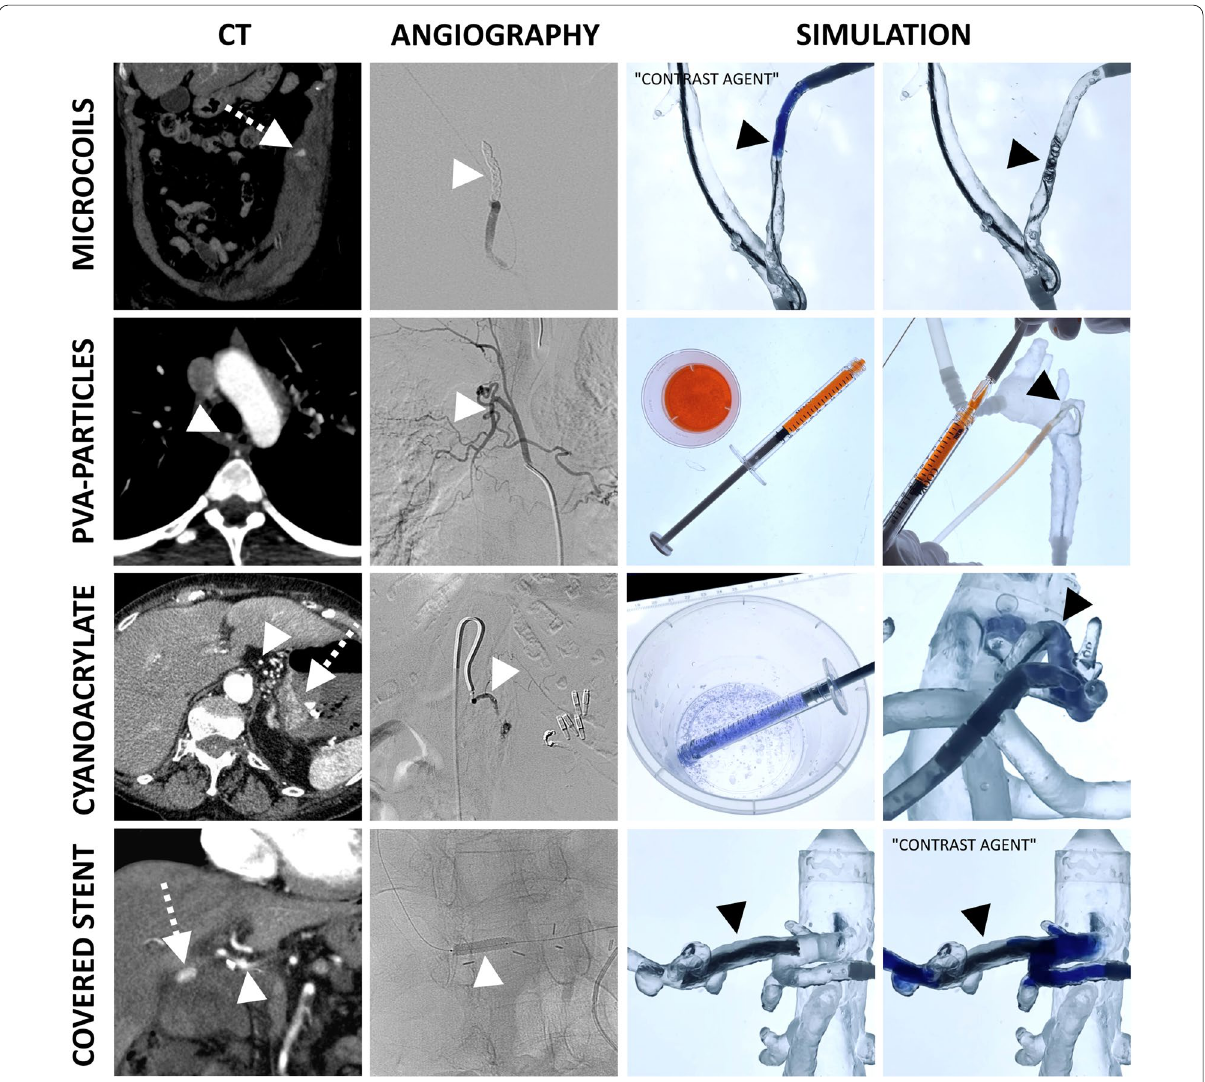
Fig. 6 Embolic agents. This figure demonstrates the different embolic agents used in this simulation setting. White arrows with dotted lines active bleeding. White and black arrowheads procedure-relevant artery. Blue colored disappearing ink was used to replace contrast media, = which quickly resolves within seconds to become invisible in this closed circulatory system. PVA particles were mixed with an orange colored saline solution for better visibility. For the same reason, Histoacryl (light blue) was used for n-butyl cyanoacrylate